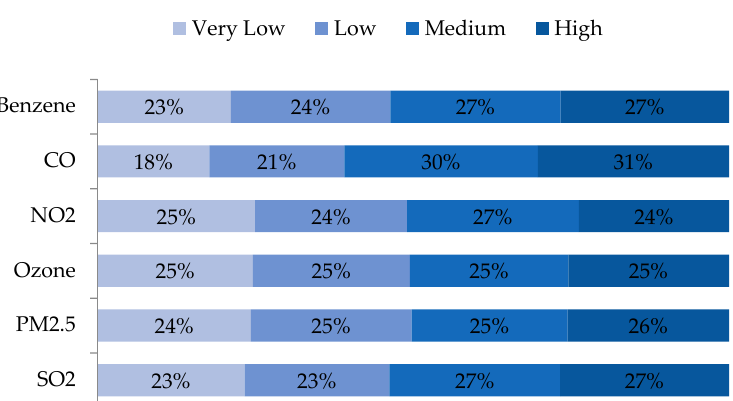
Figure 9. Distribution of exposure category based on WA metrics, for all observations with ambient air measurements indicating ‘Medium’ exposure, by pollutant.